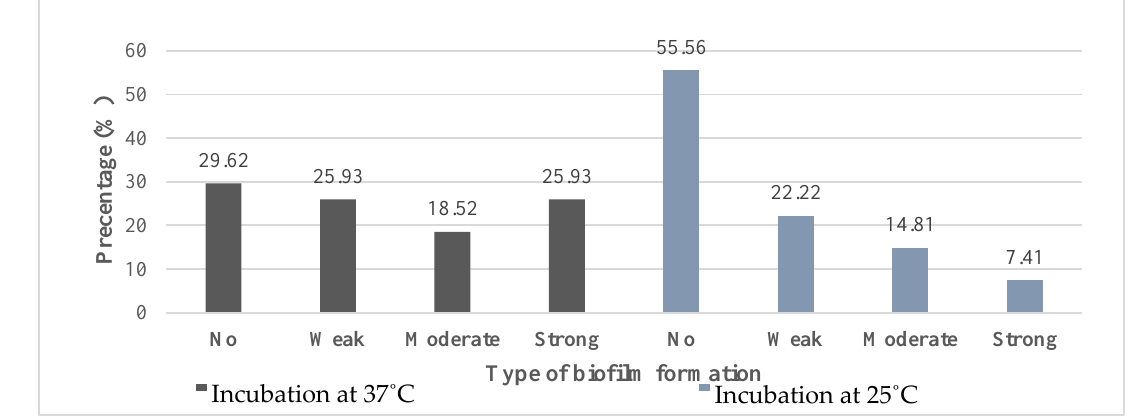
Figure 5. Percentage of Acinetobacter baumannii according to biofilm formation ability.